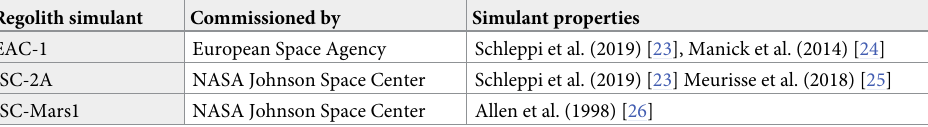
Table 1. Overview of the regolith simulants used and experiments performed in this paper. Regolith